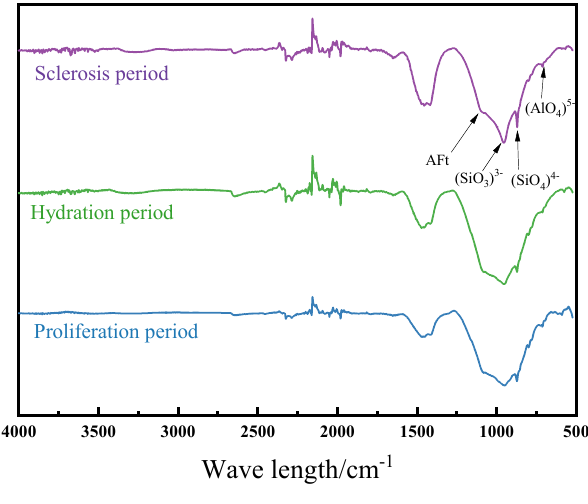
Figure 10. FT-IR spectrum of CFTFM.